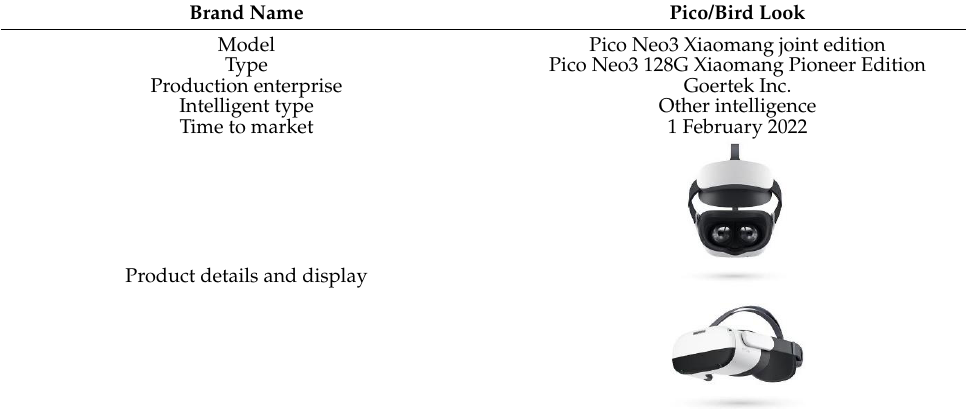
Table 1. Equipment